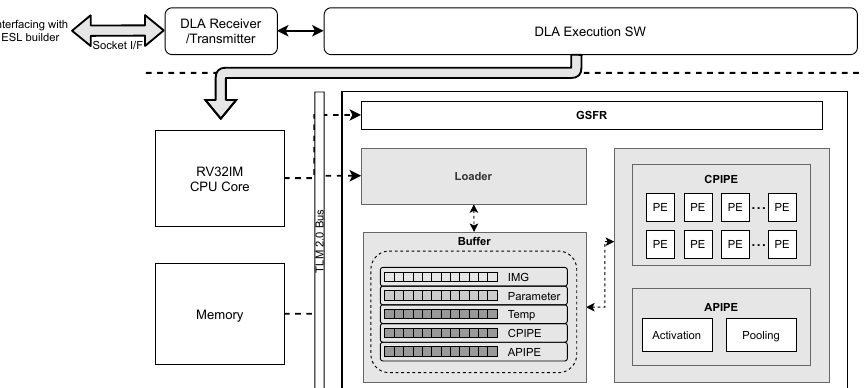
Figure 5. DLA architecture consists of GFSR, Buffer, Loader, and PIPE